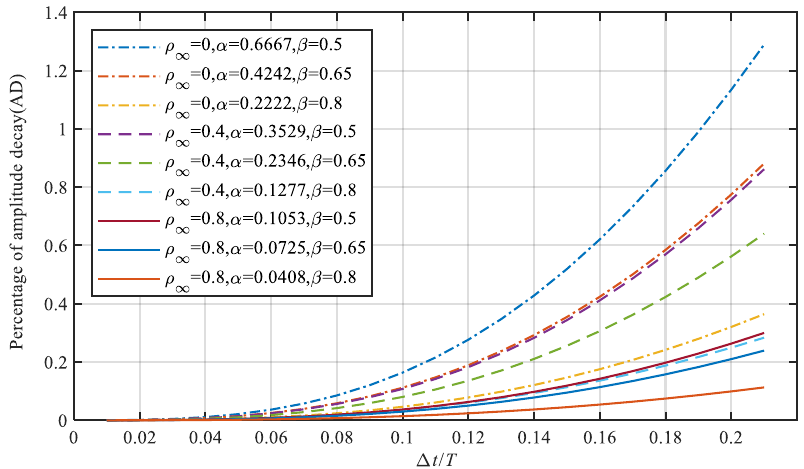
Figure 3. Percentage of amplitude decay of the proposed method with different numerical damping.